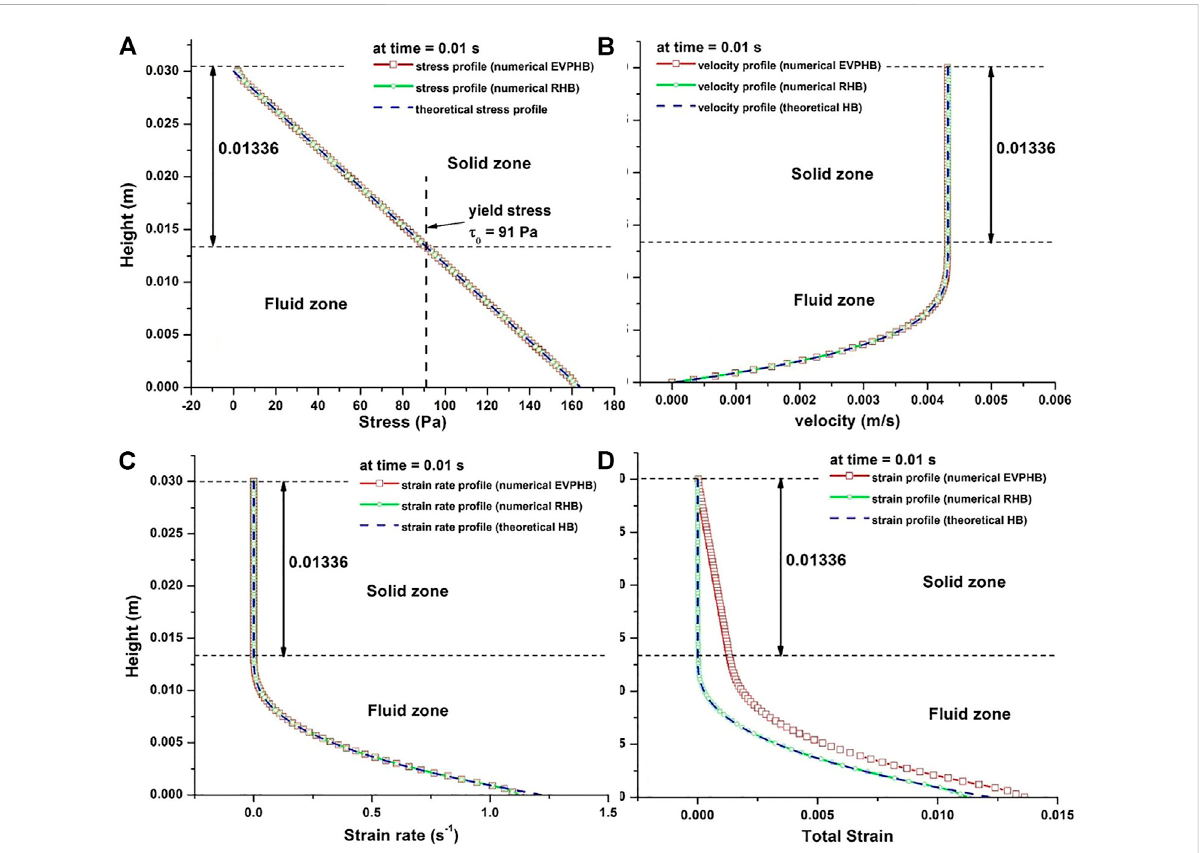
FIGURE 6 (A) Stressdistributionindepthdirection, (B) Velocitydistributionindepthdirection, (C) Shearstrainratedistributionindepthdirection, (D) Strain distribution in depth